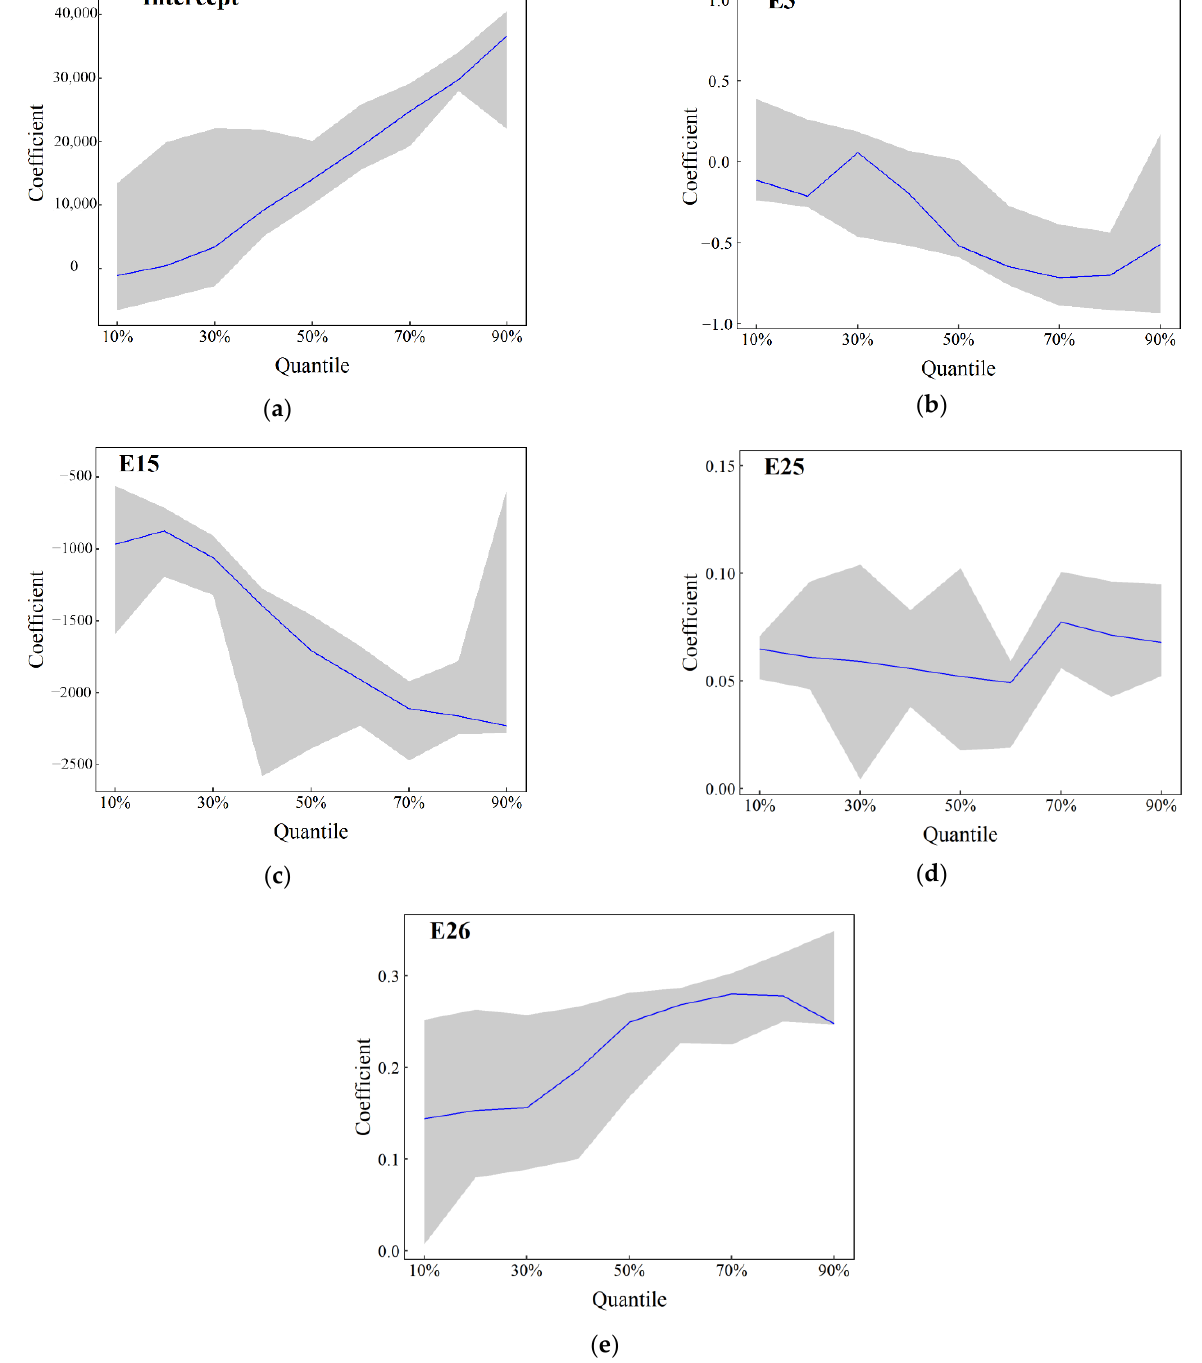
Figure 4. REM parameters at 10 – 90% quantiles. ( a ) Coefficient of intercept at 10 – 90% quantile. ( b ) Coefficient of E3 at 10 – 90% quantile. ( c ) Coefficient of E15 at 10 – 90% quantile. ( d ) Coefficient of E25 at 10 – 90% quantile. ( e ) Coefficient of E26 at 10 – 90% quantile. at 10–90% quantile. ( e ) Coefficient of E26 at 10–90%